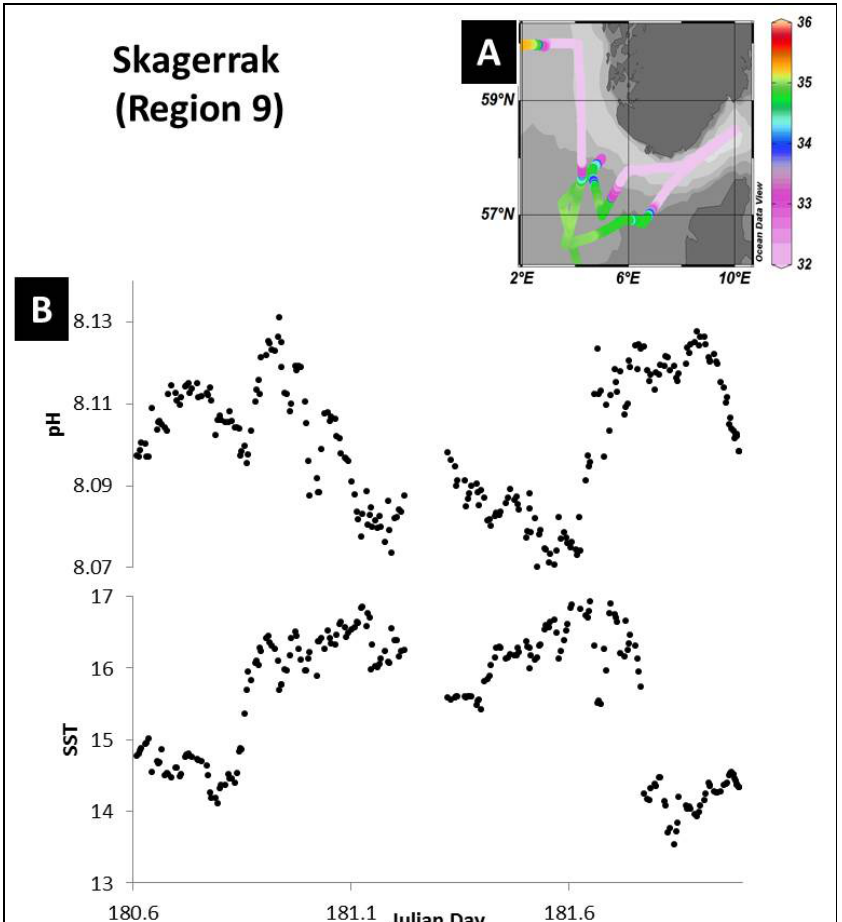
Figure 8. Impact of temperature on sea surface pH distributions. ( A ) Map of sea surface salinity observed during the cruise D366 in the Skagerrak region (region 9). ( B ) Sea surface pH and temperature plotted versus Julian day for the Skagerrak region. Map was produced using Ocean Data View (Schlitzer, R., Ocean Data View, odv.awi.de, 2017).